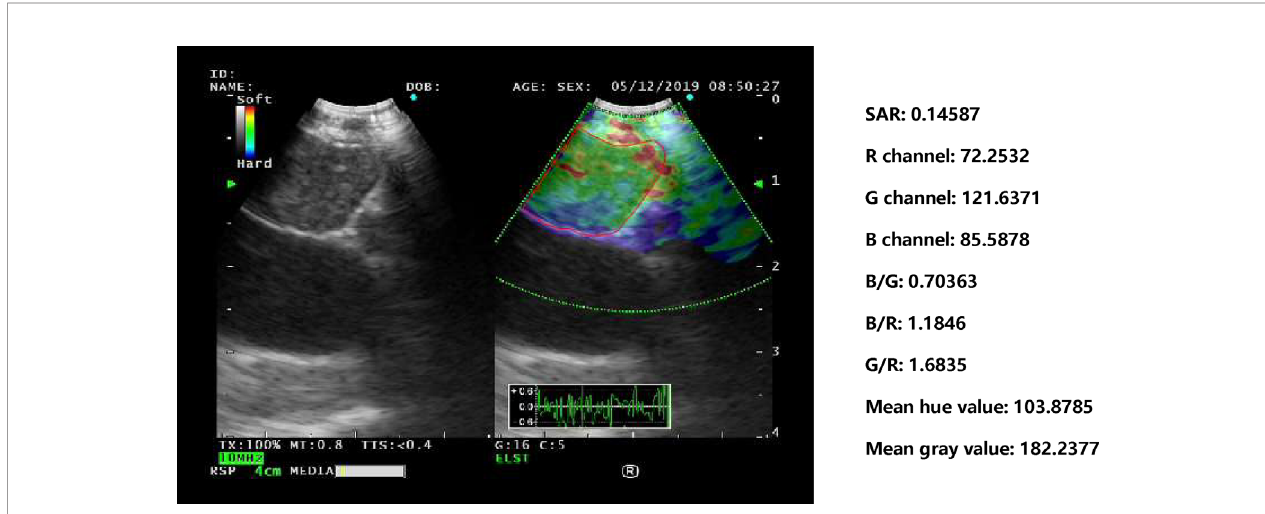
FIGURE 2 | Delineation of ROI on strain elastography images and output of quantitative parameters. Representative images of the machine learning group, expert group and trainee group were all input into a computer program developed by Matlab ™ . The schematic diagram showed an elastography image of a LN with nonspeci fi c lymphadenitis in 4R station, and ROI was outlined on the elastography image. Results of the four quantitative methods including SAR, RGB, mean hue value and mean gray value were then output by the program. ROI, region of interest; LN, lymph node; SAR, stiff area ratio; B/G, elasticity ratio of blue/green; B/R, elasticity ratio of blue/red; G/R, elasticity ratio of